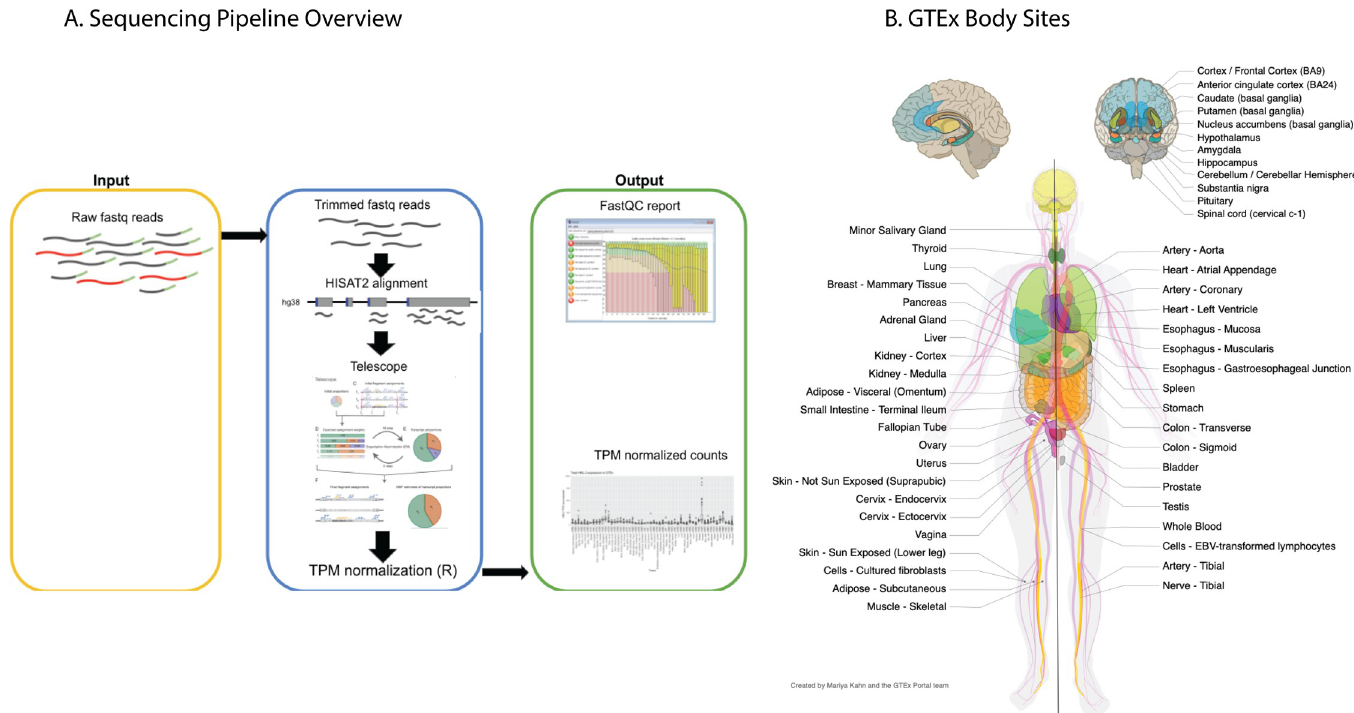
Fig 2. Analysis of the GTEx dataset. ( A ) Schematic overview of the sequencing pipeline used in this study. See Materials and methods for further information. ( B ) Diagram of all body sites samples in the GTEx project, copied from the GTEx portal, with permission. Not listed is 1 cell culture, a chronic myelogenous leukemia line derived from a GTEx donor. EBV, Epstein–Barr virus; GTEx, Genotype Tissue and Expression; TPM, transcripts per